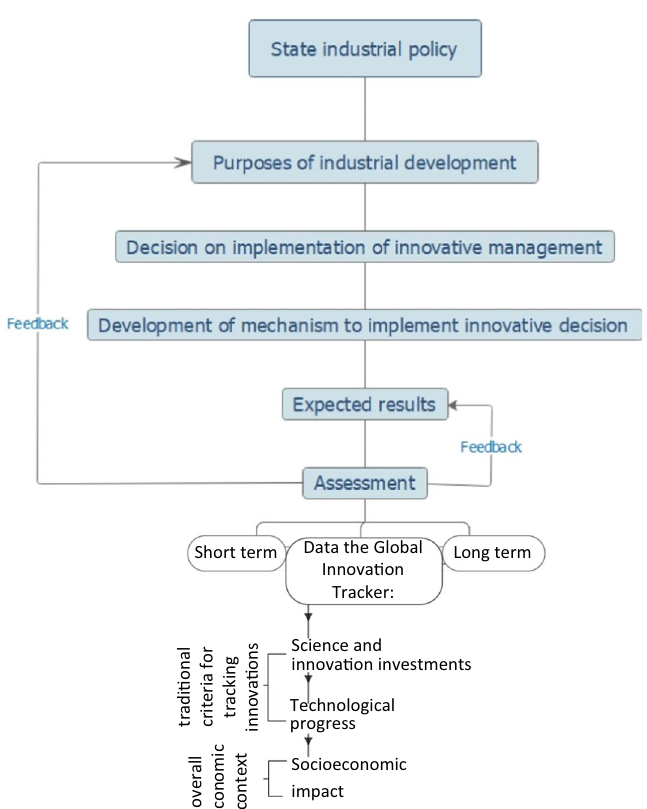
Fig. 3 Mechanism for implementing innovative management in industrial sector. Source: developed by the authors based on Dutta et al. (2020), Dutta et al. (2021), WIPO Statistics Database